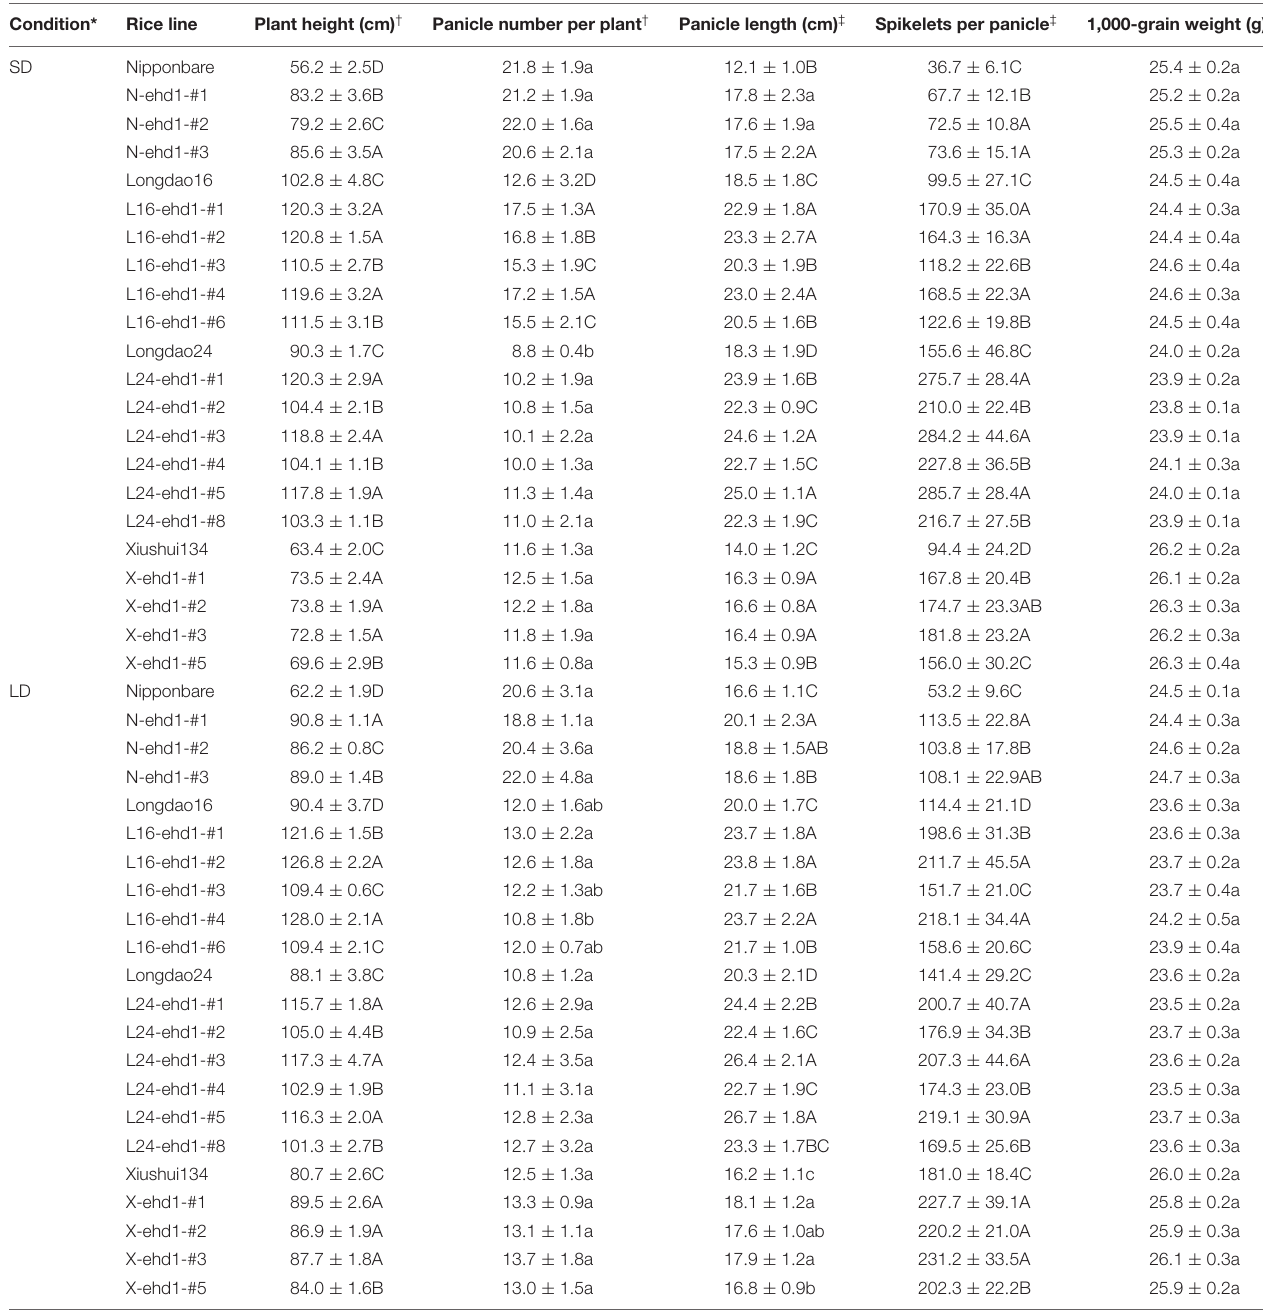
TABLE 2 | Major agronomic traits of the ehd1 mutant lines under both SD and LD. Condition* Rice